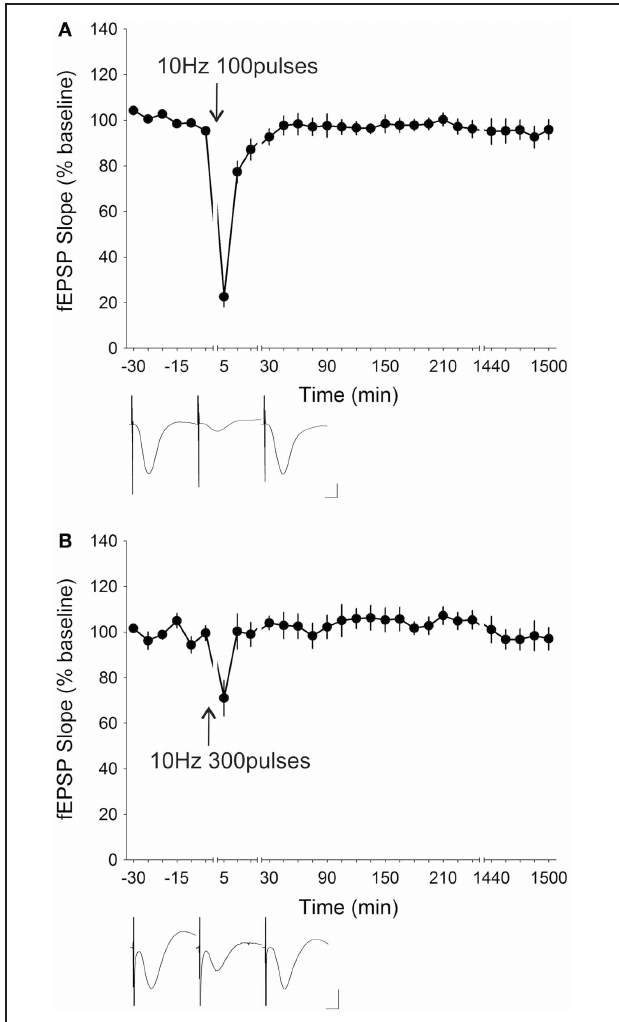
FIGURE 9 | Stimulation at 10Hz resulted in varying degrees of synaptic depression depending on the number of stimuli administered. (A) Low-frequency stimulation (LFS) given at 10Hz for 100 pulses induced robust STD with an initial synaptic depression of 22 . 55 ± 4 . 39% and a significant depression that lasted 15min post-LFS (ANOVA, p < 0 . 01; n = 15). (B) Increasing the number of stimuli at 10Hz to 300 pulses strongly ameliorated the STD resulting in an initial depression of 71 . 02 ± 7 . 82% which persisted for 5min post-stimulation (ANOVA, p = 0 . 71830). Insets: analog traces illustrating the Schaffer collateral–CA1 field potentials at pre-stimulation, 5min and 24h (1440min). Vertical scale bar corresponds to 2mV and horizontal scale bar corresponds to